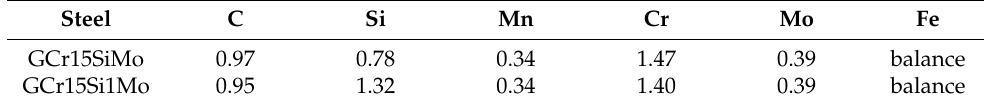
Table 1. Chemical compositions of the experimental steels